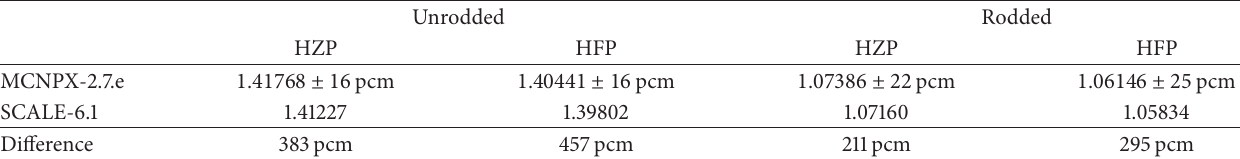
Table 2: 𝑘 values for the different states of the 15 × 15 TMI fuel assembly obtained by MCNPX-2.7e and SCALE-6.1, taking the SCALE eff results as the reference for the difference in pcm.